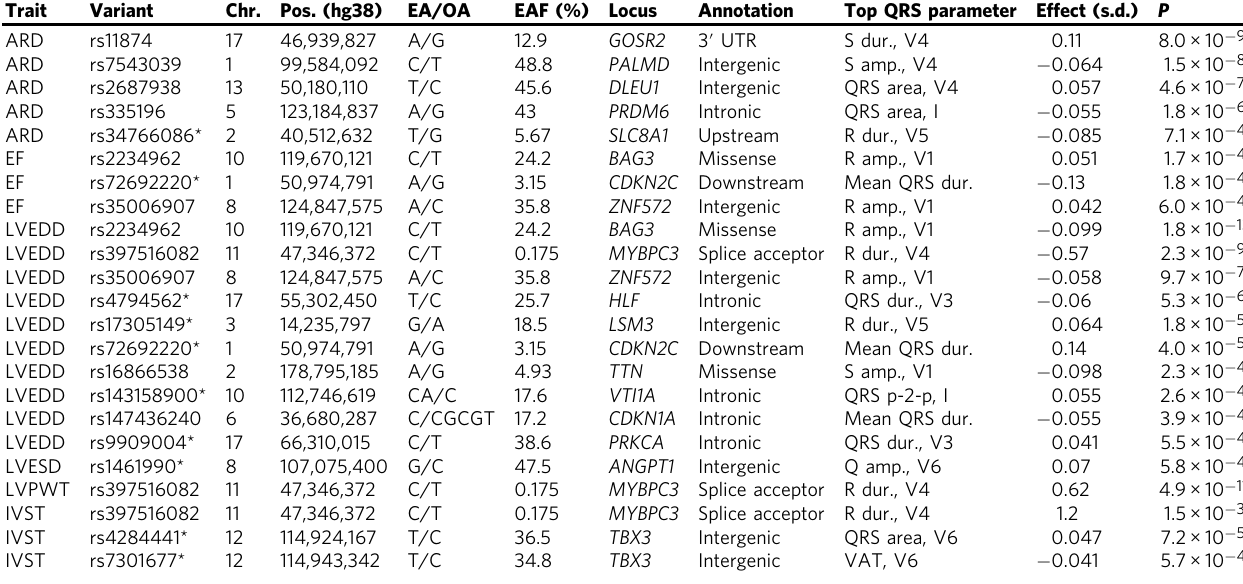
Table 1 Associations between the QRS variants and echocardiographic traits Trait